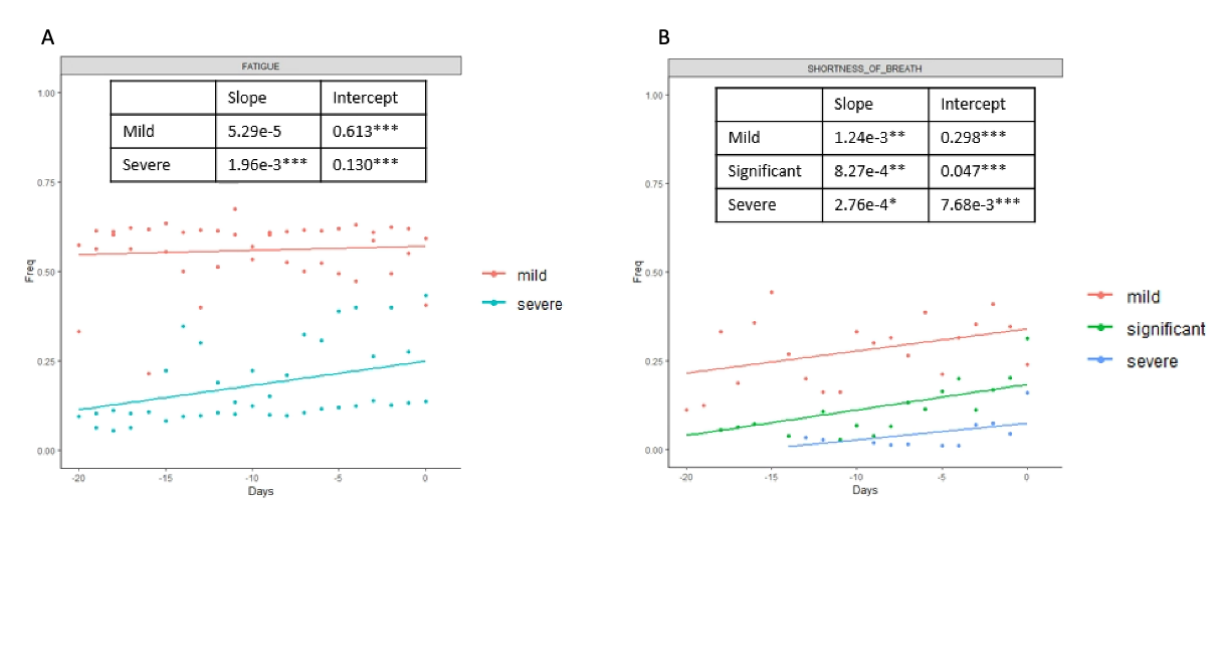
Figure 3. Categorical features of fatigue and shortness of breath are plotted for the positive group in longitudinal